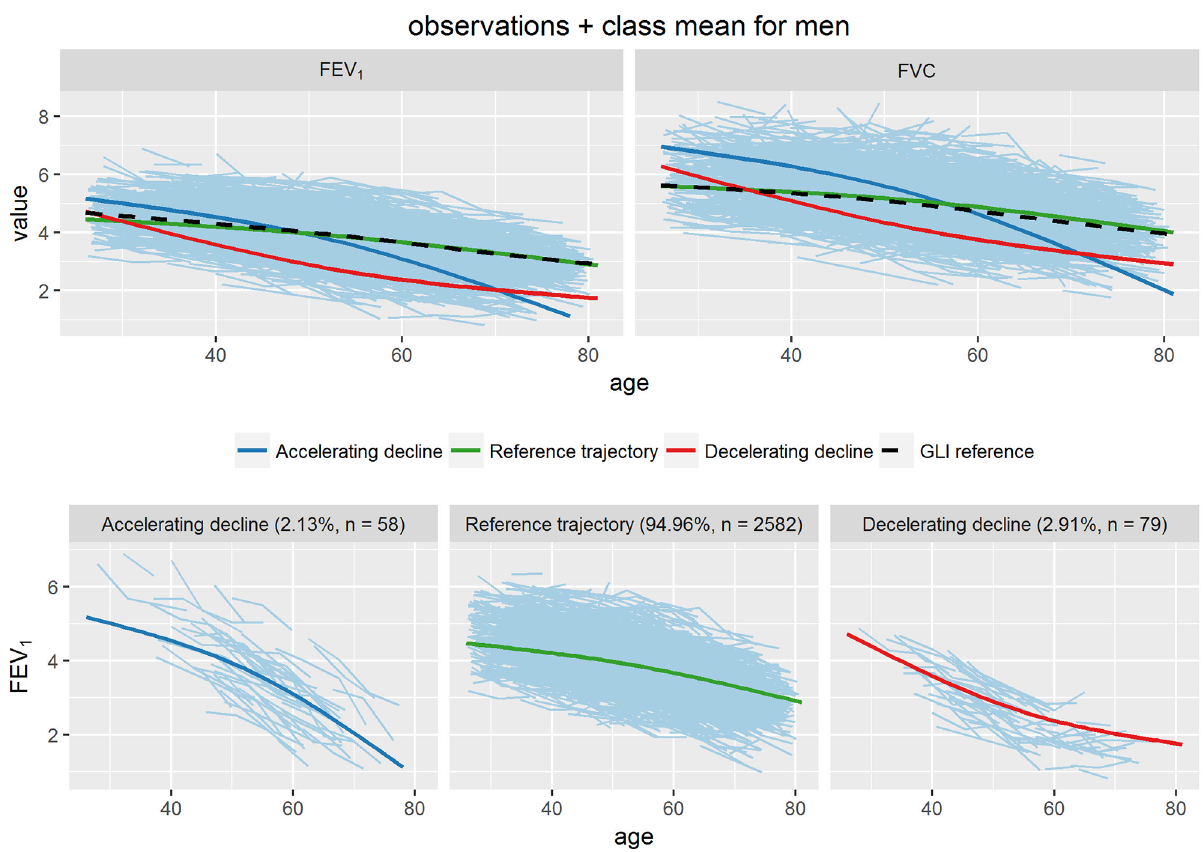
Fig 1. Trajectories of FEV 1 (Liters) for men. The curves in the upper left panels of the figure represent the ‘average’ FEV 1 trajectory for the individuals in each group, after classification into groups based on the greatest probability of class membership. The upper right panels show the FVC trajectories for these groups. The bottom panels display the individual FEV 1 curves of the members of each group